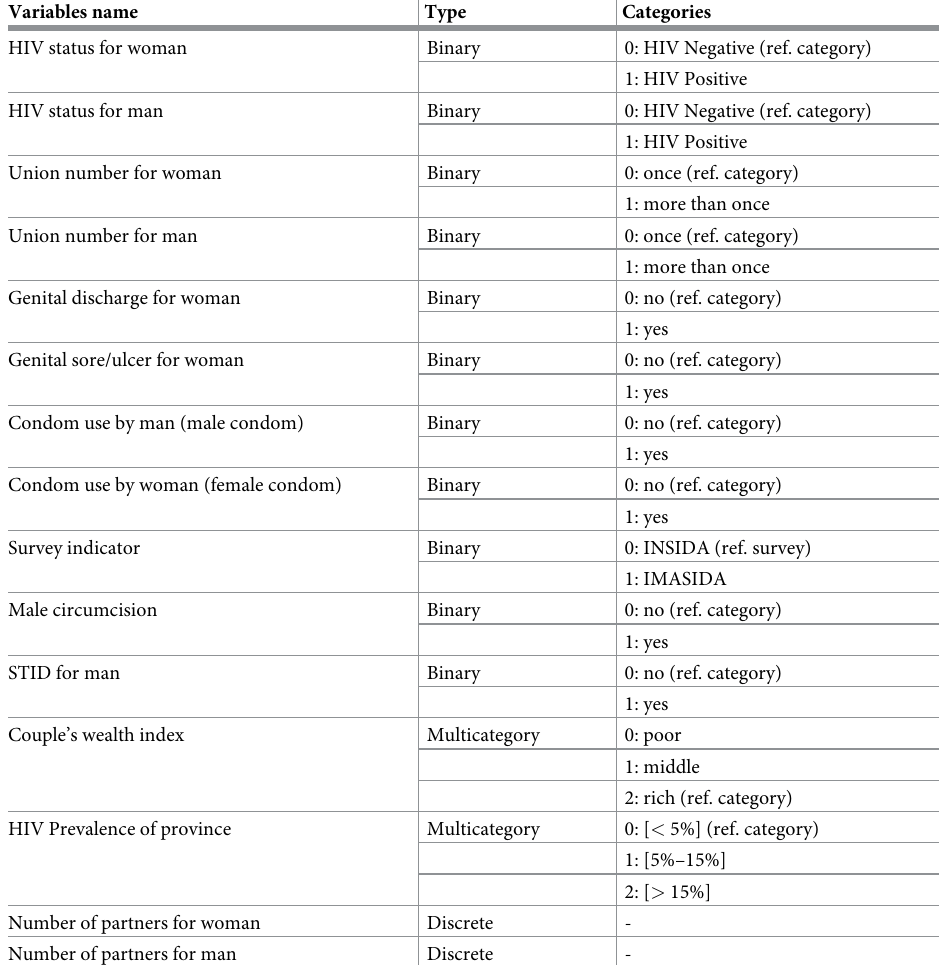
Table 1. INSIDA and IMASIDA variables: Basic description of